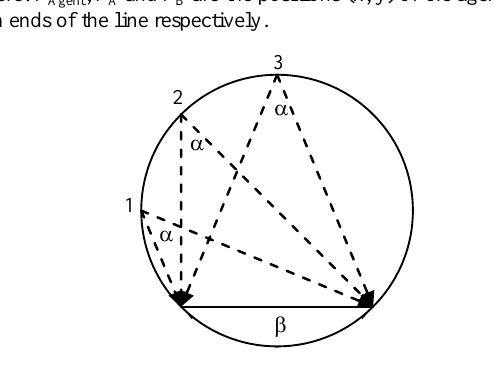
Figure 4. The locus of all points in the area having the same see angle to the line